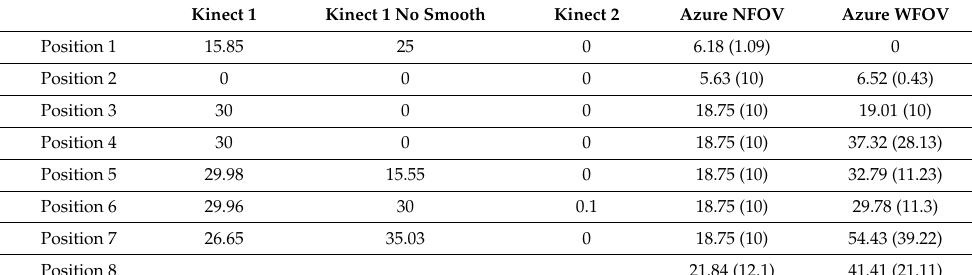
Table 2. Percentage of undetected joints for each sensor and position.